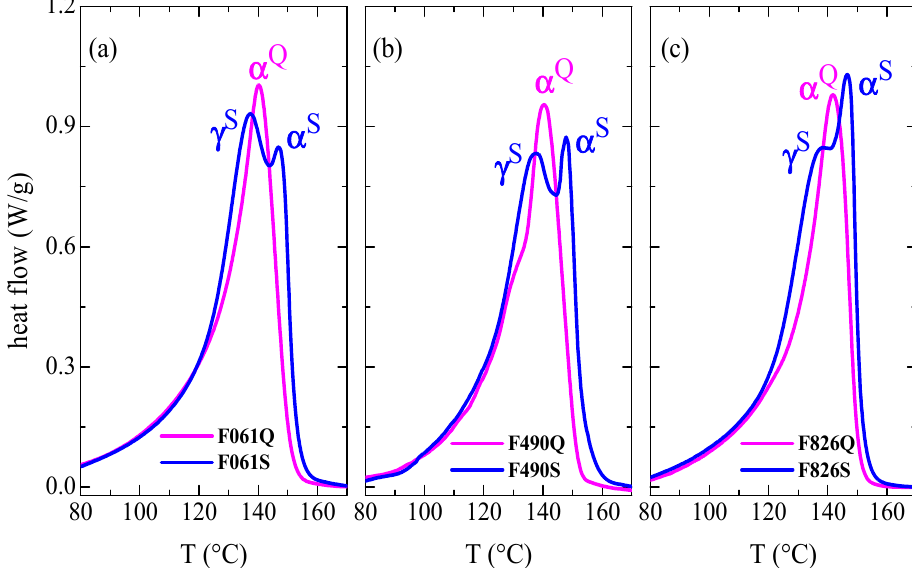
Figure 3. First DSC melting curves obtained from quenched and slowly cooled (Q and S) films prepared from the different new pipes: ( a ) P061; ( b ) P490; and ( c ) P826.